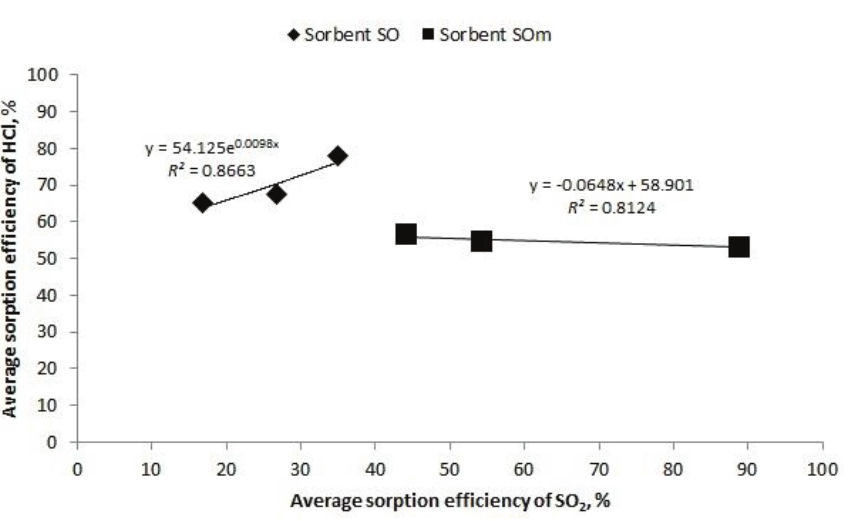
Fig. 17 – Correlation of the average sorption efficiency of SO introduction of Fig. 16 Correlation of the average sorption efficiency of SO 2 and HCl after the introduction of sorbents